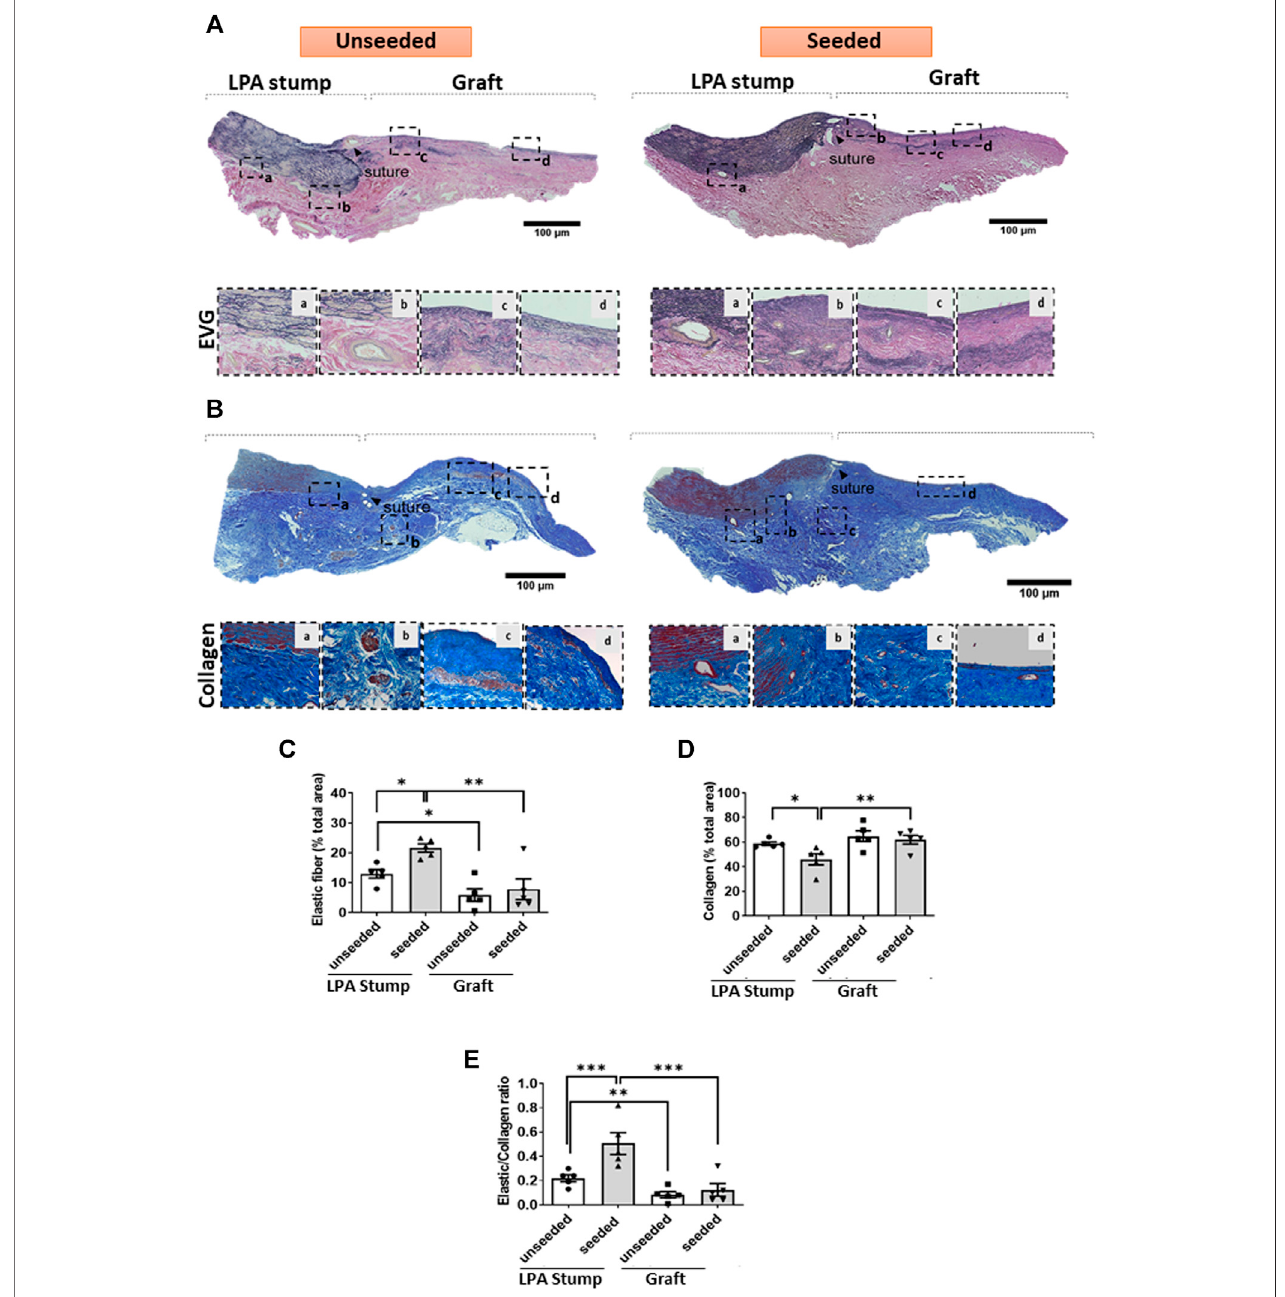
FIGURE6 | ECMremodeling of the implanted artery. (A,B) Tiled images and inserts at higher magni fi cation display the composition ofelastic fi bers ofthe LPA and graft,asassessedusingEVG (A) andAzanMallory (B) stainings. (C – E) Bargraphsshowingtheresultsofthequanti fi cationofelastinandcollagenandtheirratio.Images were visualized using a light microscope with 2.5x, 10x and 20x objectives. N (cid:1) 5 biological replicates per experimental group. per experimental group. Data are expressed as mean ± SEM. * p < 0.05, ** p < 0.01, and *** p < 0.001.